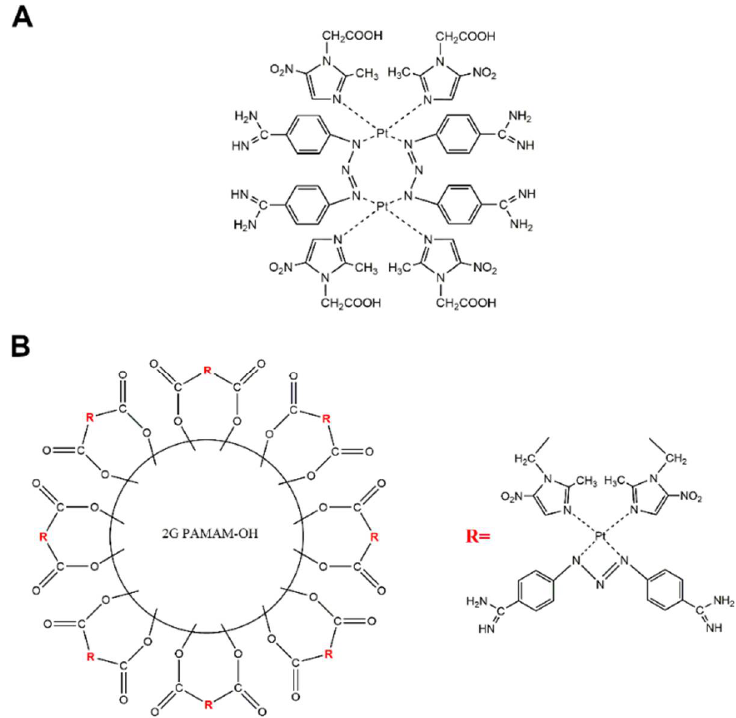
Figure 1. Chemical structures of PtMet2 ( A ) and PtMet2–PAMAM ( B ).